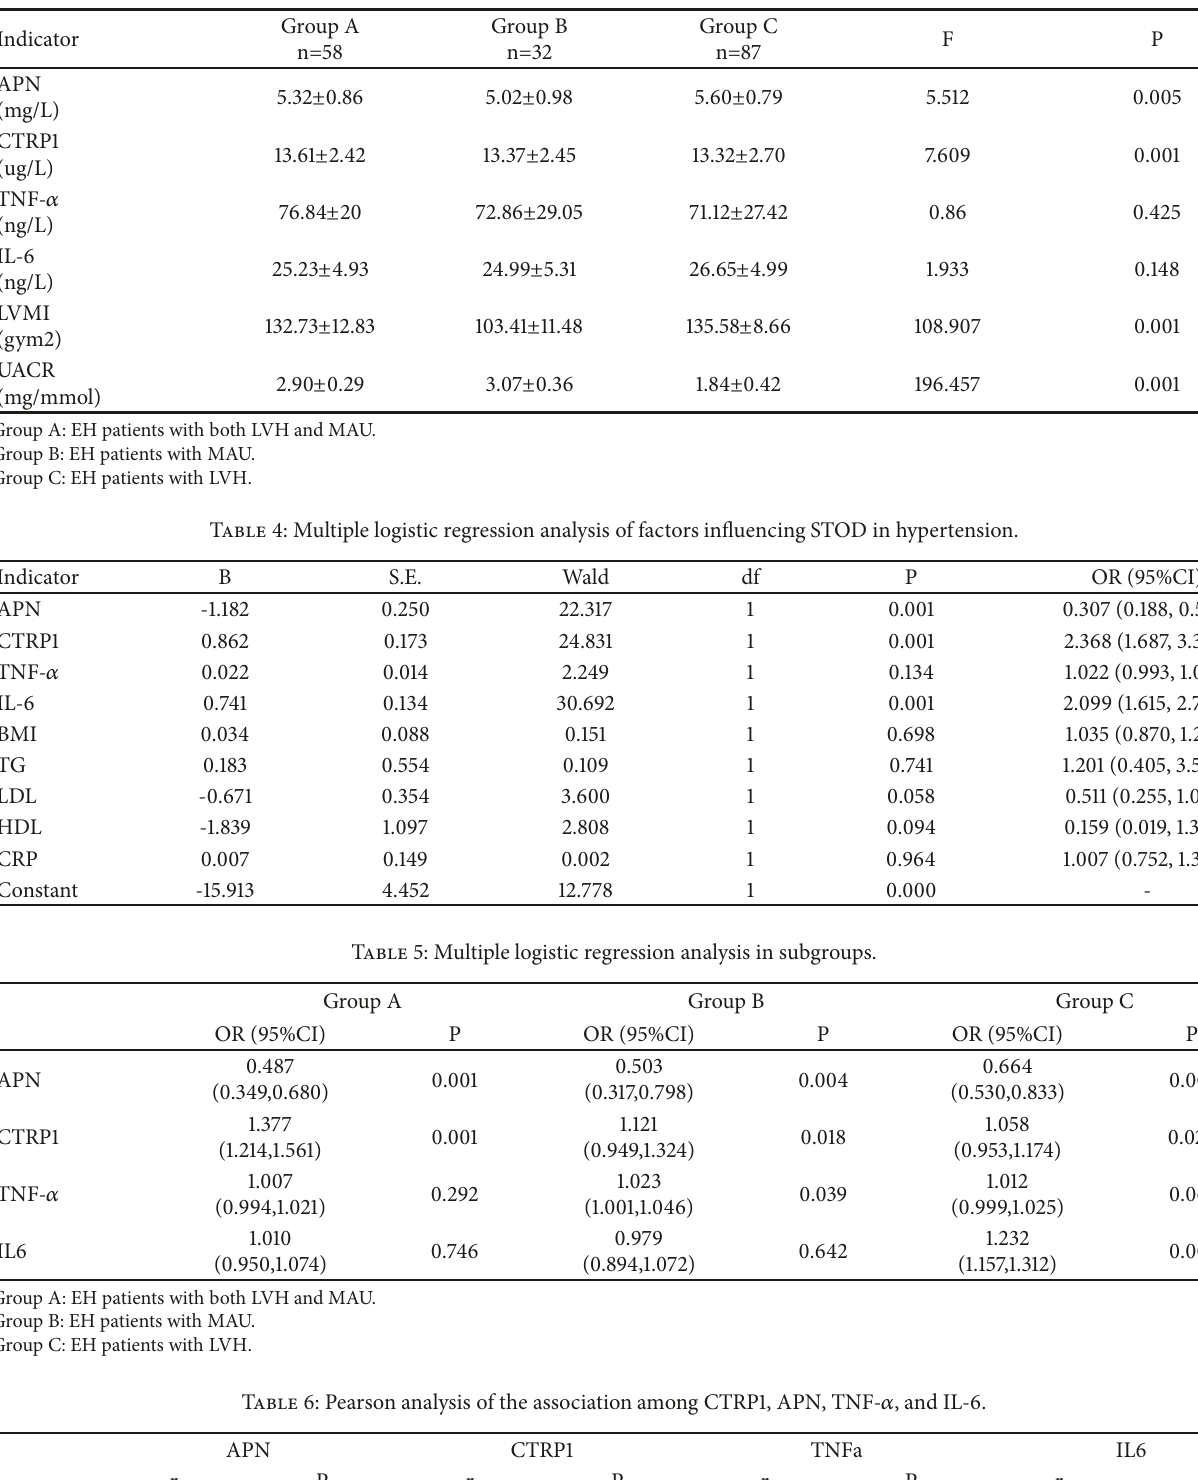
Table 3: Characteristics among three subgroups (x ± s).